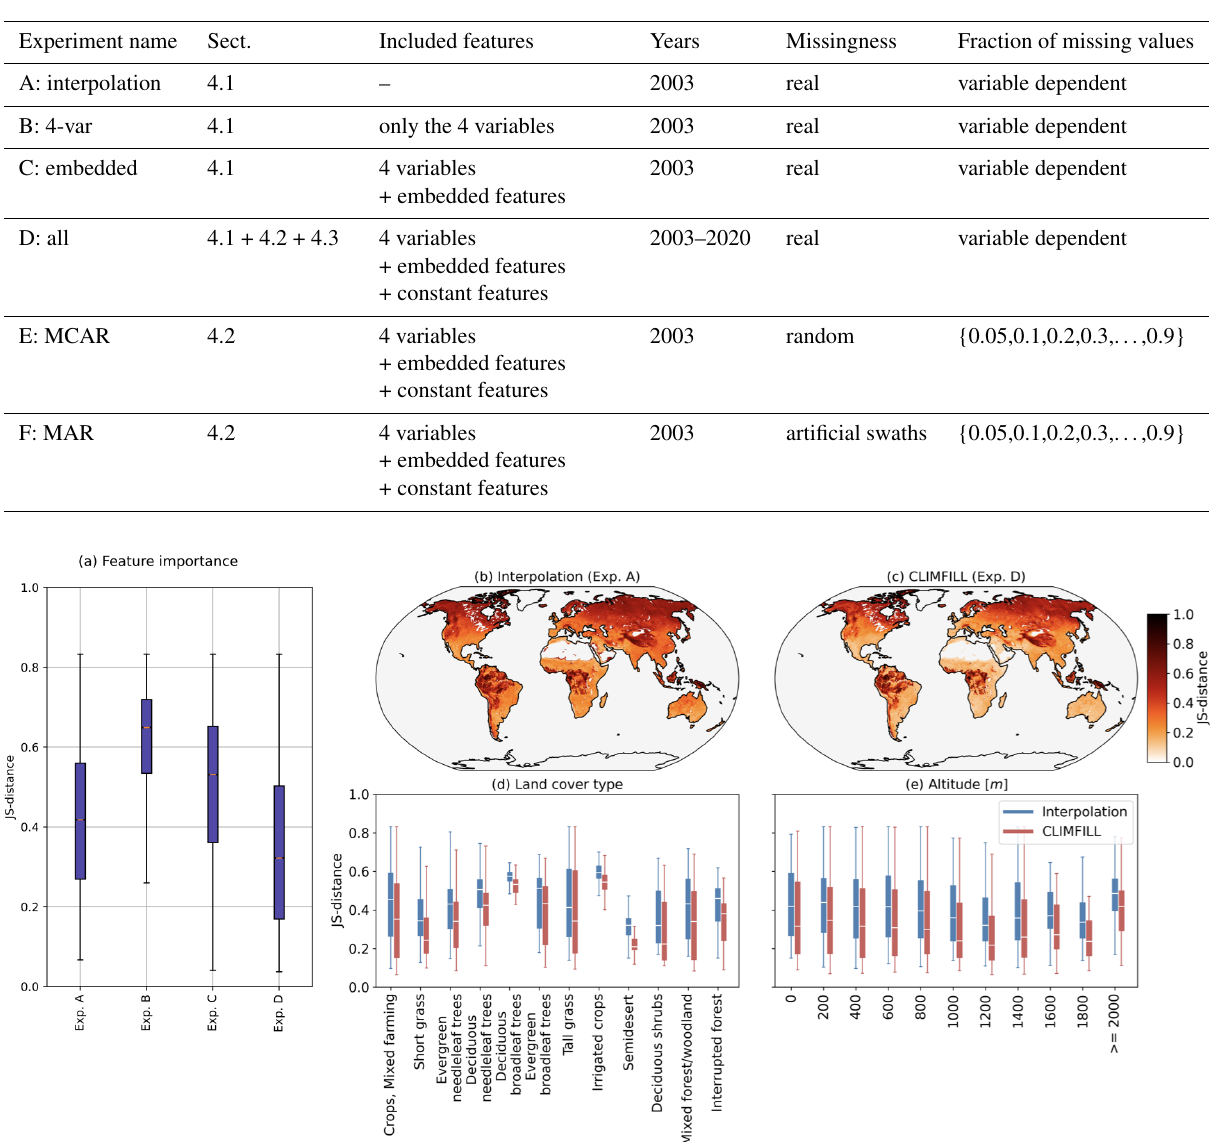
Figure 6. Multivariate Jenson–Shannon (JS) distance for interpolation and CLIMFILL gap-filling processes. (a) Boxplots of JS distance between original the ERA-5 data and the interpolation, as well as all sets of features as described in Sect. 2.2. (b) Map of JS distance of univariate interpolation and (c) CLIMFILL considering the multivariate distribution of all variables. (d) JS distance per land cover type and (e) altitude for interpolation gap filling and CLIMFILL gap filling. Land cover type and altitude are extracted from ERA-5. Boxplots show the median as a white line, the box shows the upper and lower quartiles, and the whiskers are 1.5 times the quartile length over all land points with the specified land cover type or